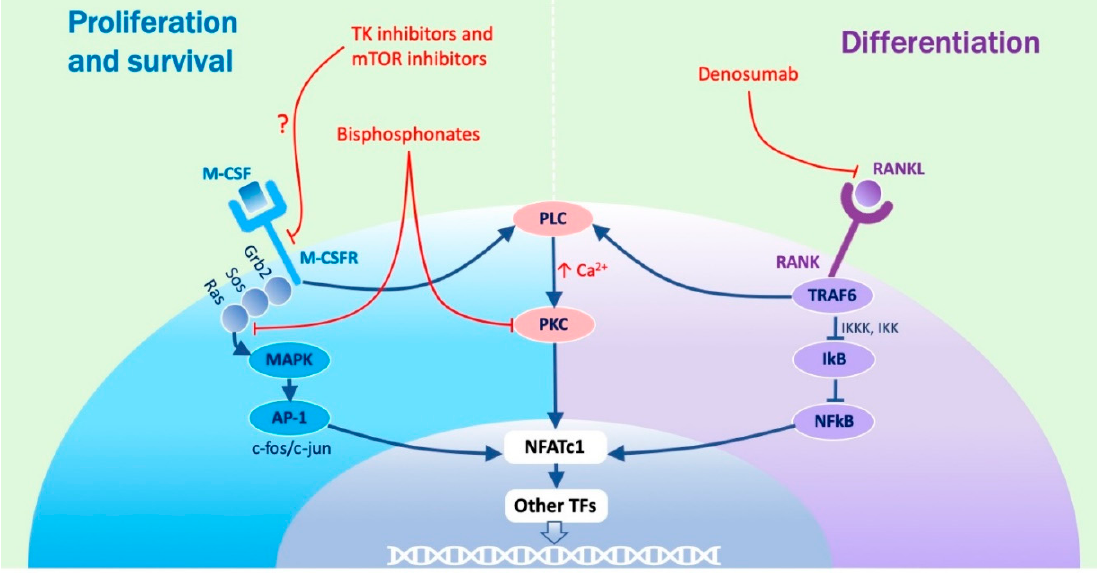
Figure 2. The molecular regulation of osteoclast di ff erentiation. Osteoclast formation is regulated by M-CSF and RANKL. M-CSF binds to its receptor (M-CSFR), a tyrosine kinase receptor encoded by the c-fms gene, triggering the mitogen activated protein kinase (MAPK) phosphorylation cascade and leading to the activation of the activator protein -1 (AP-1) transcription factor which up-regulates the expression of genes promoting cell proliferation. On the other hand, RANKL, acting through its receptor RANK, inhibits inhibitor of NF κ B (I κ B) which sequesters nuclear factor kappa-light-chain-enhancer of activated B cells (NF κ B) under basal conditions, thus leading to the consequent release and nuclear translocation of this transcription factor. Once activated, NF κ B induces the expression of nuclear factor of activated T-cells cytoplasmic 1 (NFATc1)—the master regulator of osteoclastogenesis), the activity of which is also aided by AP-1. Both M-CSFR and RANK are able to stimulate the phospholipase C (PLC)—protein kinase C (PKC) pathway, which contributes to NFATc1 activation. The final and common e ff ect of the three pathways is represented by an increased transcription of osteoclast di ff erentiation markers. Anti-resorptive agents and their molecular targets are indicated in red inside the figure. Arrows mean activation, T bars mean inhibition. TK, tyrosine kinase; mTOR, mammalian target of rapamycin.